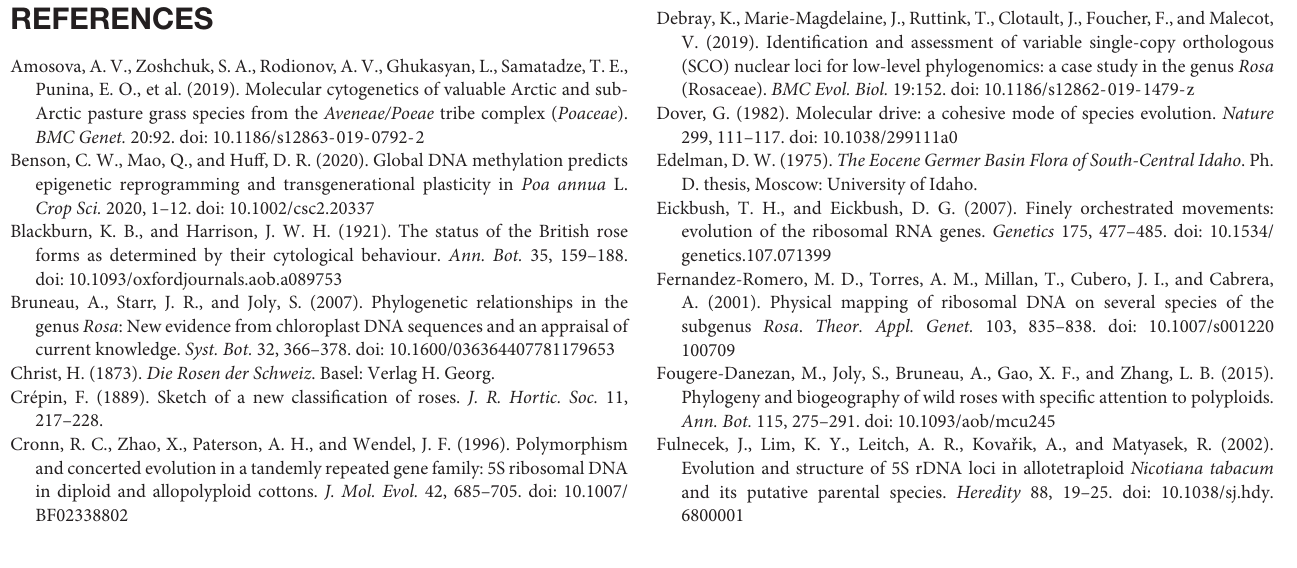
Supplementary Figure 1 | Genomic analysis of 5S rDNA variants. Projections of 5S rDNA cluster graphs in polyploid Rosa species. Loops representing the IGS